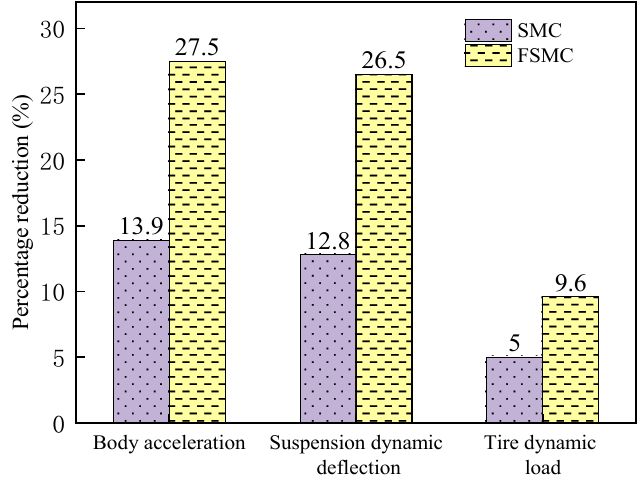
Figure 21. Percentage reduction of peak response under impacted pavement surface.